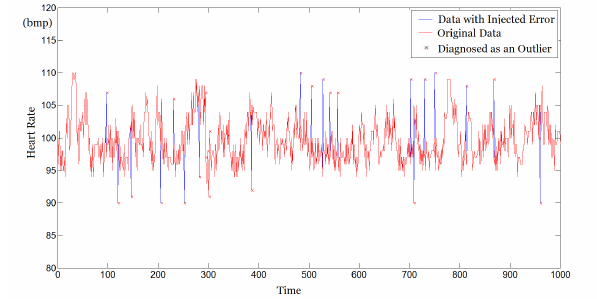
Figure 4. Outlier